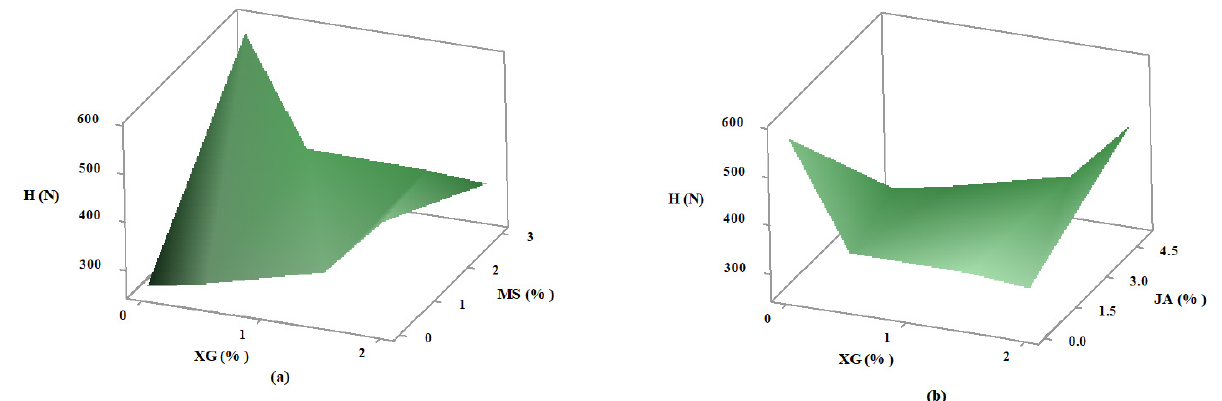
Figure 5. Response surface plot of the correlative effects of ( a ) maple syrup (MS) and xanthan gum (XG); ( b ) Jerusalem artichoke (JA) and XG on the hardness (H) of walnut butter. The highest values of L* for walnut butter samples with MS and XG are observed in the upper right corner of the plot which correspond with higher values of XG (Figure 6a), while the lowest values of L* for walnut butter samples with JA and XG are found in the lower left corner of the plot, which correspond to lower values for XG (Figure 6b).